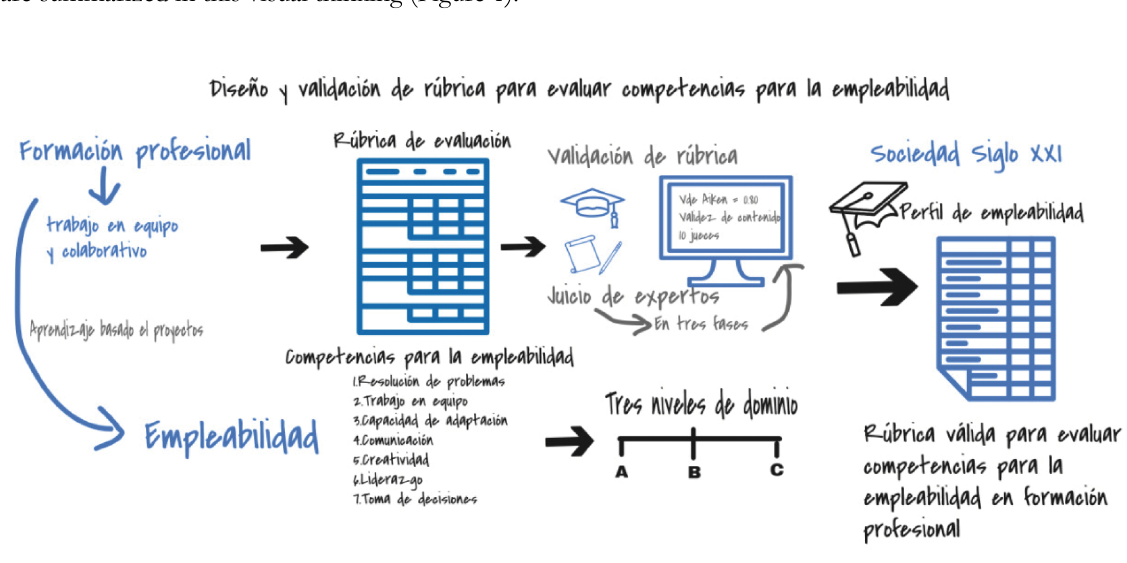
Figure 1. Visual thinking which summarizes the study carried